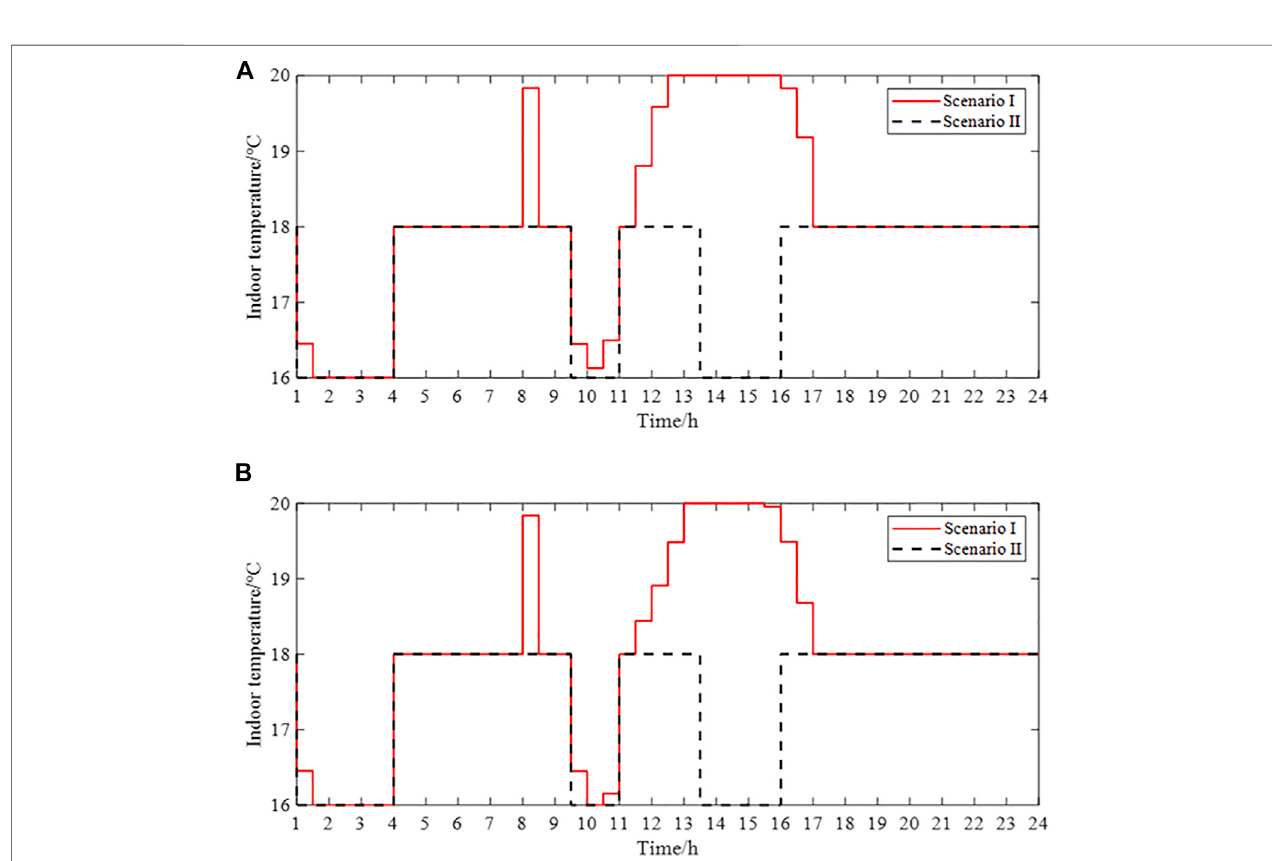
FIGURE10| Correspondingindoortemperaturewhen theoptimal scheduling results are f opt- and f opt+ . (A) Indoortemperature when the optimal scheduling result is f opt - . (B) Indoor temperature when the optimal scheduling result is f opt +